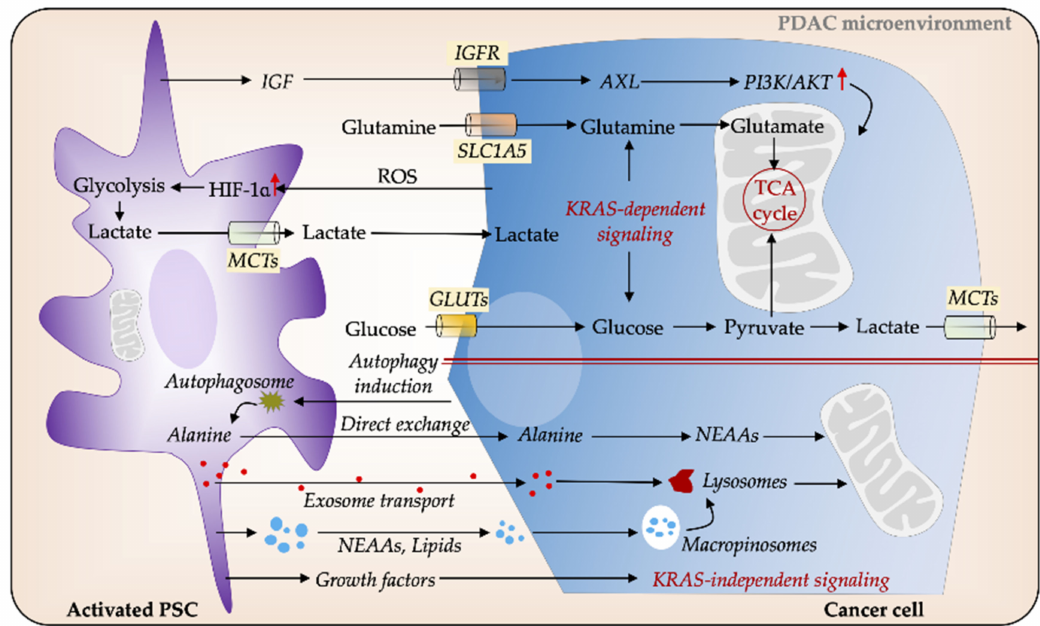
Figure 3. PSCs facilitate metabolic reprogramming in PDAC. Cancer cells secrete reactive oxygen species (ROS), which induces glycolysis in PSCs, thereby increasing the release of nutrients such as lactate, which in turn feed the energy demands of cancer cells. Several cytokines and signaling pathways mediate metabolic interactions between PSCs and PC cells via KRAS-dependent pathways. Insulin-like growth factor (IGF) increases mitochondrial respiration in cancer cells via IGFR/AXL axis. Glucose and glutamine are major sources of carbon for cancer cells. PSCs-secreted non-essential amino acids (NEAAs), such as autophagy-induced alanine, can serve as an alternative energy source to fuel cancer cells. Cancer cells can obtain nutrients from extracellular proteins for supporting their growth through upregulated macropinocytosis. In addition, PSCs-derived growth factors (GFs) and exosomes play a pivotal role in cancer cell metabolic balance. GLUT, glucose transporter; MCT; monocarboxylate transporter; PDAC, pancreatic ductal adenocarcinoma; PSC, pancreatic stellate